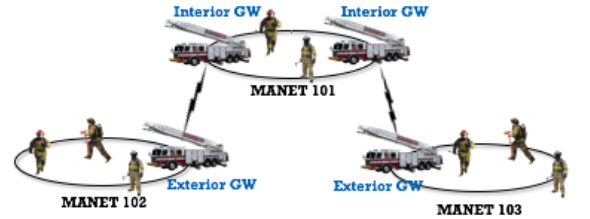
Figure 17. SDN-based Ad hoc Inter-domain Routing Protocol